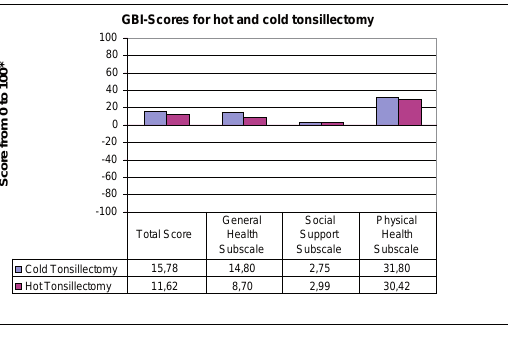
Sociodemographic and clinical character- istics of the total sample, as well as the two treatment groups CT and HT.